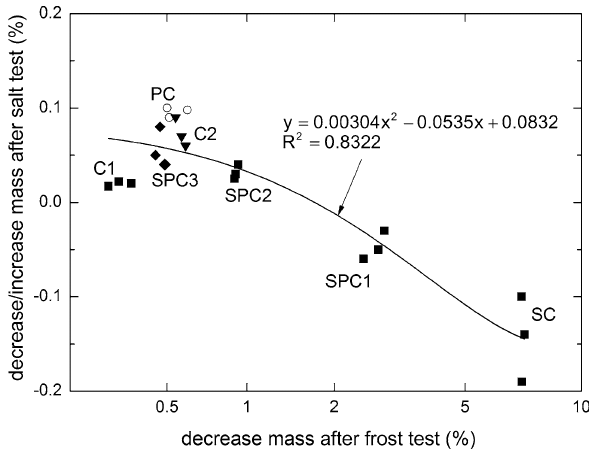
Fig. 10 Relationship between percentage of mass loss after frost and salt resistance tests.